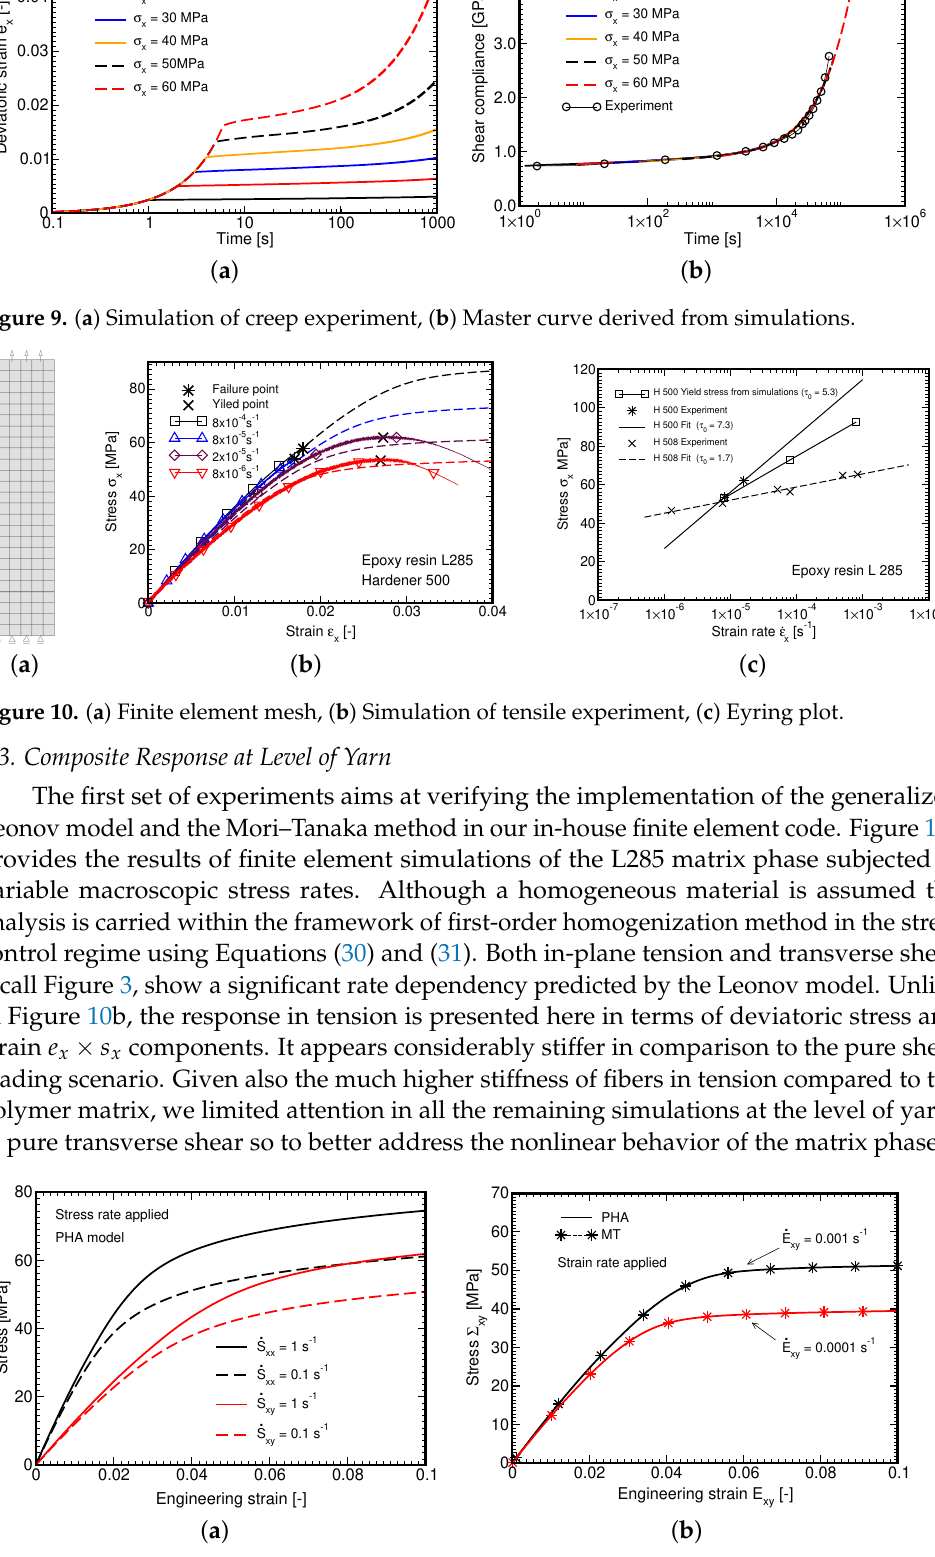
Figure 11. Nonlinear viscoelastic response of L285 ( a ) Stress–strain diagrams for two different strain rates provided by FEM (stress control loading); ( b ) Stress–strain diagrams for two different strain rates provided by FE and MT methods (strain control